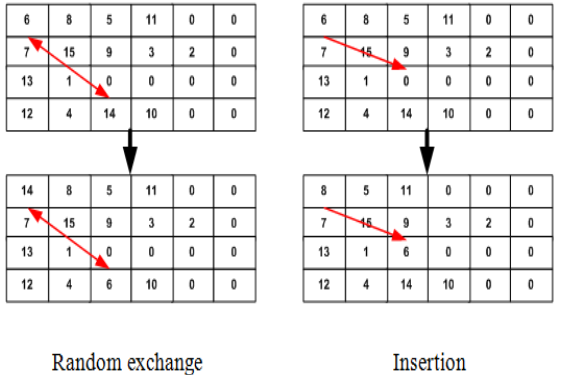
Figure 4: Mutation operators used in GA for CPP: Between different